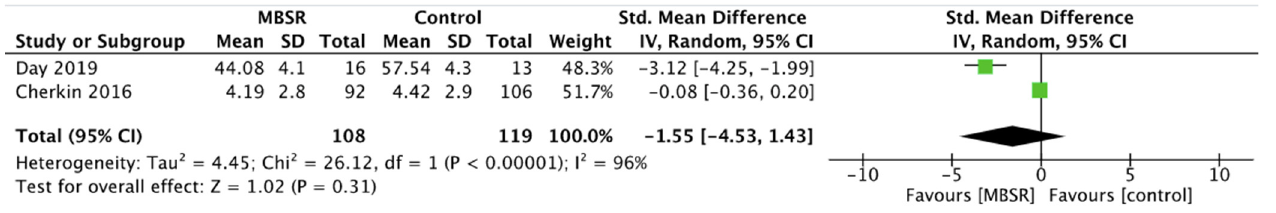
Figure 10. Depression: CBT versus control.